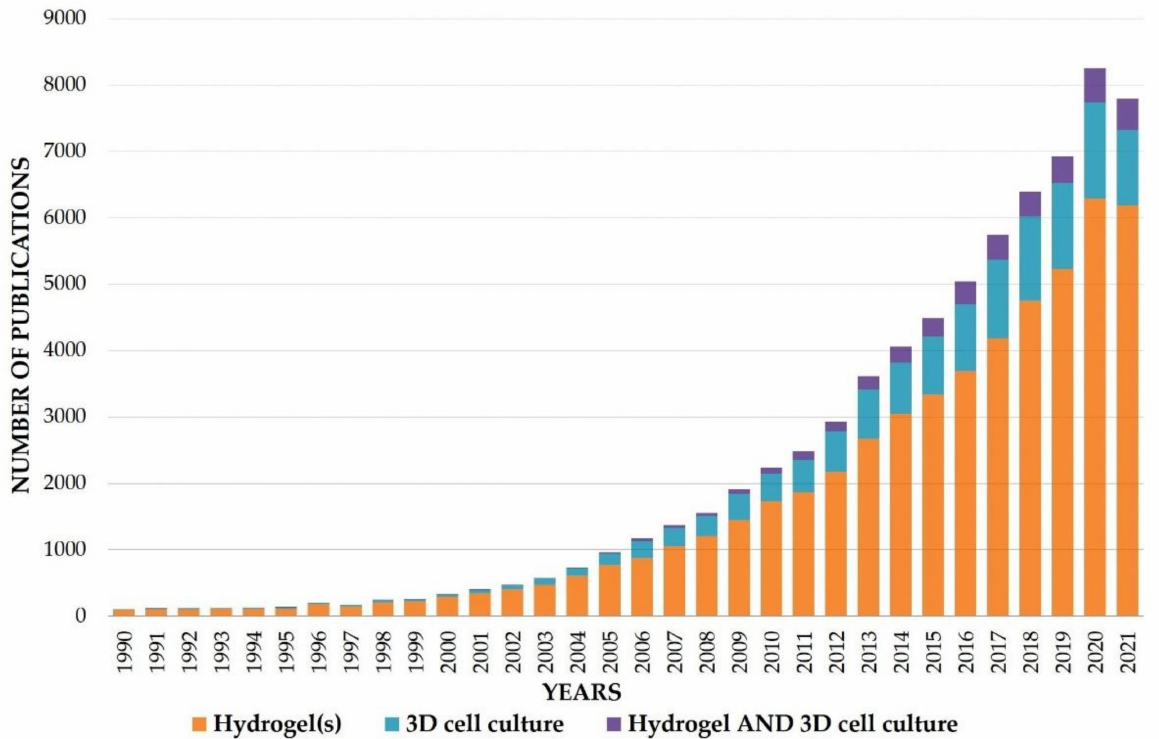
Figure 1. Number of publications related to “hydrogels” and “3D cell culture” from 1990 onward. The total number of studies was calculated based on data from PubMed (www.pubmed.ncbi.nlm.nih.gov (accessed on 20 November